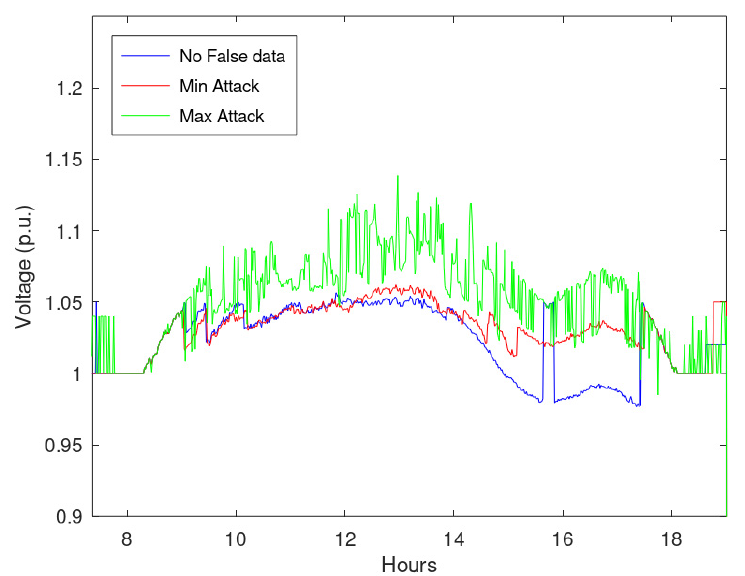
Figure 10. Maximum network voltage during the timestamps considering maximum and minimum violations, assuming that 25% of measurements are manipulated.